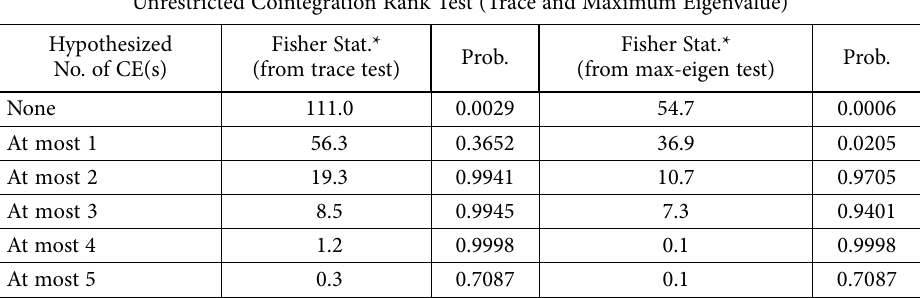
Table 8. Johansen Fisher Panel Cointegration Test (source: author’s own calculation) Unrestricted Cointegration Rank Test (Trace and Maximum Eigenvalue) Fisher Stat.* Hypothesized Fisher Stat.* Prob. Prob. (from max-eigen test) No. of CE(s) (from trace test) None 111.0 0.0029 54.7 0.0006 56.3